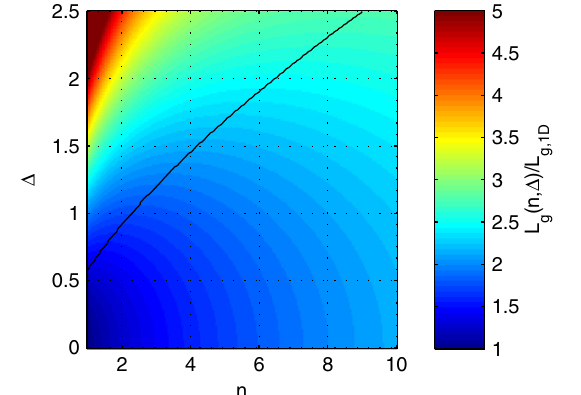
ð n; (cid:2) Þ =L as a function of g g; 1D